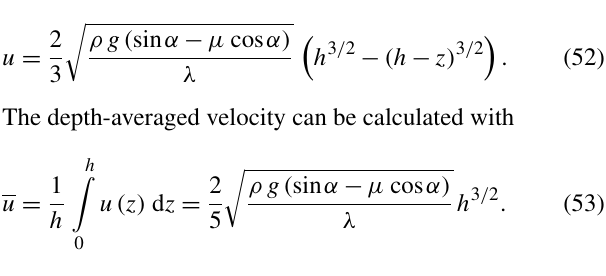
Figure 11. Orientation of the coordinate system and stresses in the slope parallel direction on an infinitesimal small control volume. Slope parallel normal stresses ( K a/p σ ) cancel each other and are not shown.